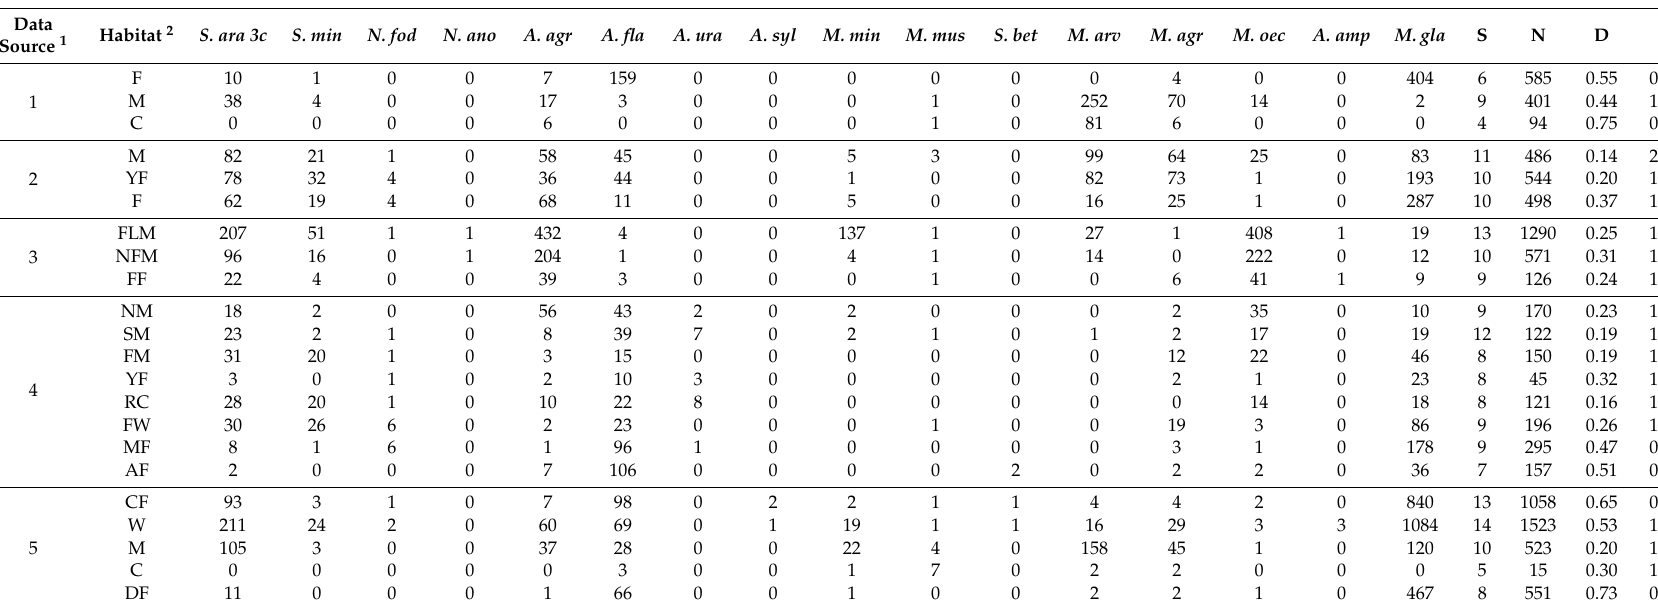
Table A1. Small mammal diversity in various habitats of Lithuania, 1981–2013 (data from published sources). Number of trapped individuals for each species presented (S—number of species, N—total number of individuals, D—dominance,